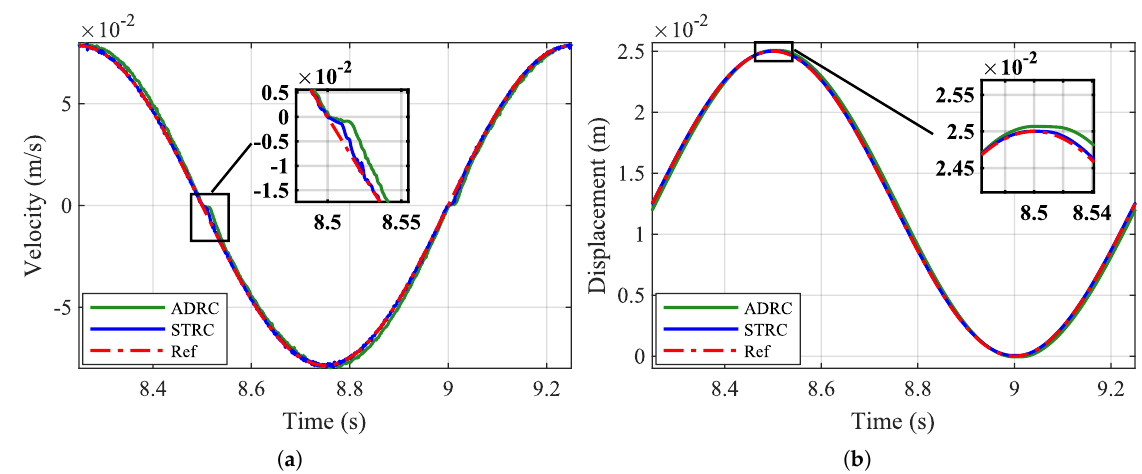
Figure 14. Experimental waveform comparison at 1.0 Hz. ( a ) Velocity; ( b ) displacement.